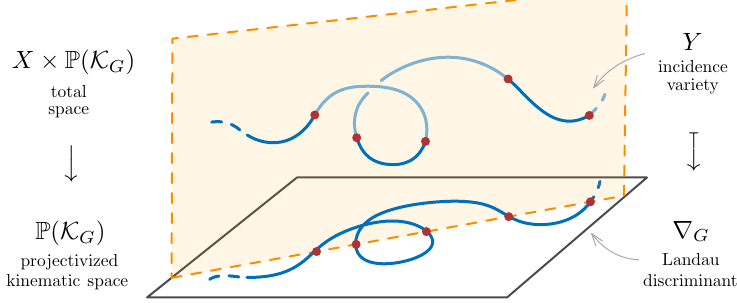
Figure 2. Diagrammatic illustration of the numerical sampling